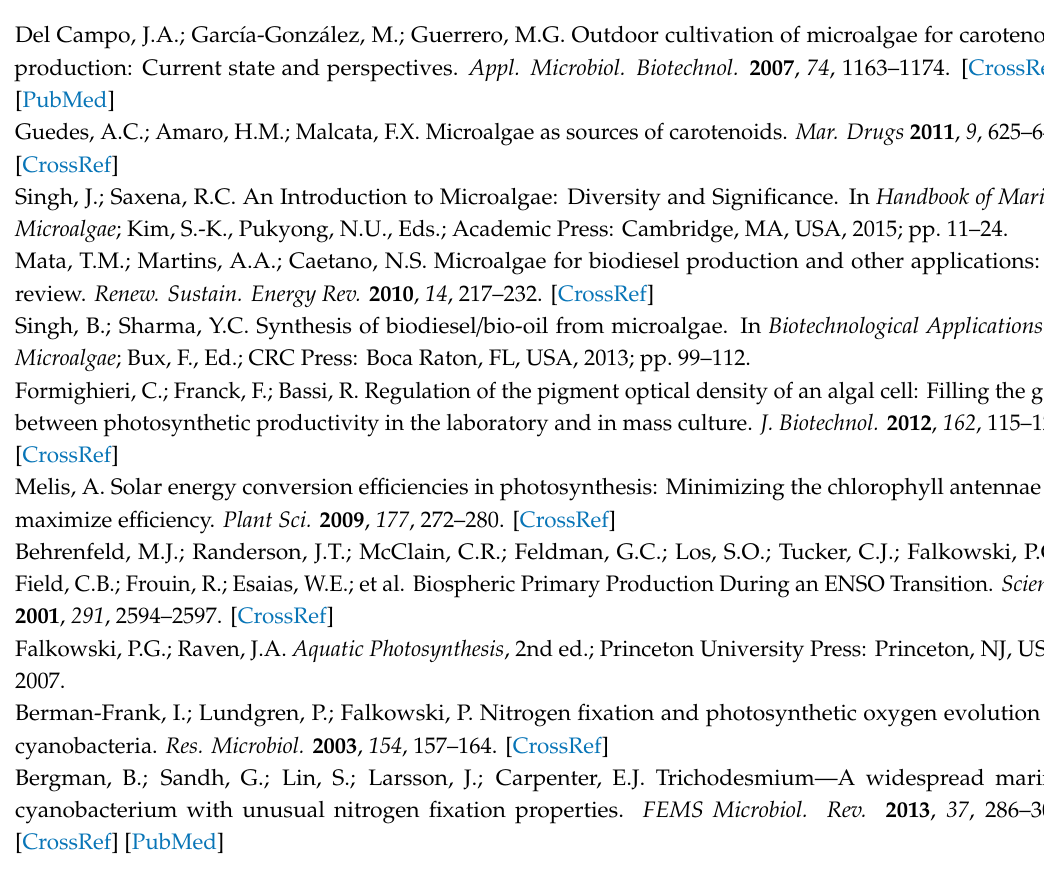
Figure S1: Calibration curve of optical density at 540 nm as a function of N. oceanica biomass dry weight, Figure S2: Growth curves of N. oceanica cultivated under process conditions 1. Values represent an average of two biological replicates, Figure S3: Growth curves of N. oceanica cultivated under process conditions 2. Values represent an average of two biological replicates, Figure S4: Growth curve of N. oceanica cultivated under process conditions 3. Values represent an average of two biological replicates, Figure S5: Temperature and instant radiation registered on site during first growth trial under process conditions 1, Figure S6: Temperature and instant radiation registered on site during second growth trial under process conditions 1, Figure S7: Temperature and instant radiation registered on site during first growth trial under process conditions 2, Figure S8: Temperature and instant radiation registered on site during second growth trial under process conditions 2, Figure S9: Temperature and instant radiation registered on site during first growth trial under process conditions 3, Figure S10: Temperature and instant radiation registered on site during second growth trial under process conditions 3, Figure S11: Microscopic picture (40 × ) of N. oceanica grown in Allmicroalgae’s pilot-scale raceway